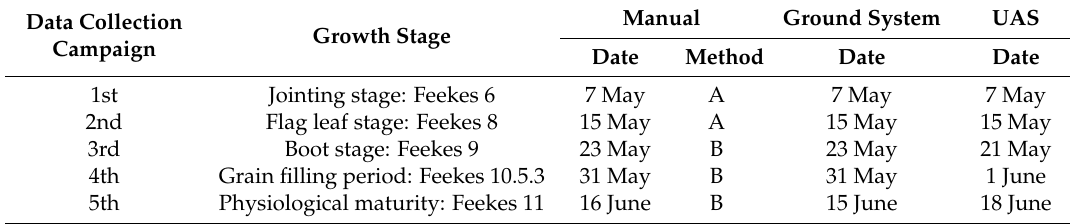
Table 1. Data collection campaign dates of manual measurement, the ground system and the unmanned aircraft system (UAS) for wheat height evaluation.